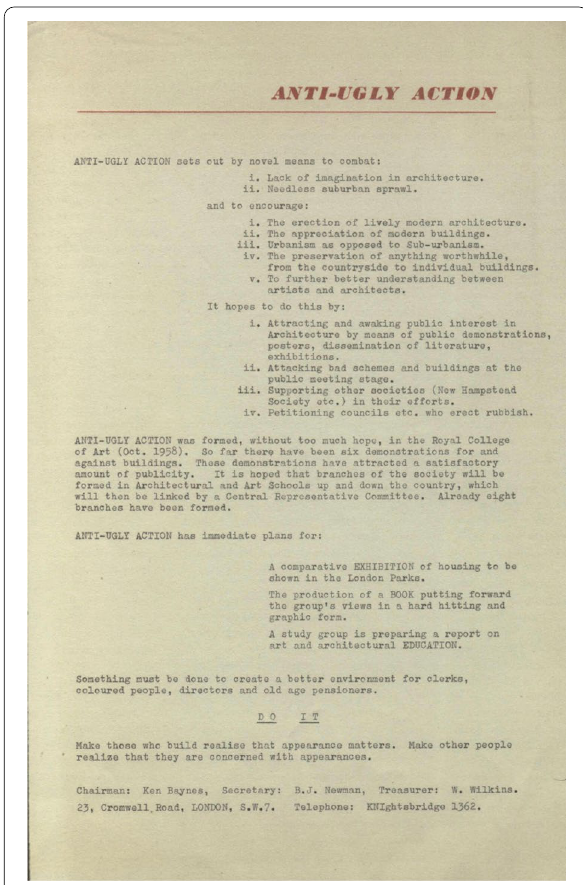
Fig. 8 Anti‑Ugly Action (AUA) manifesto, March 1959. Source: Stamp (2015)